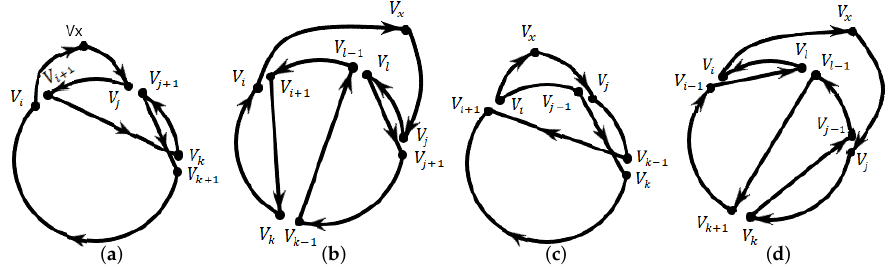
Figure 4. ( a ) Stringing Type I, ( b ) stringing Type II, ( c ) stringing Type III, and ( d ) stringing Type